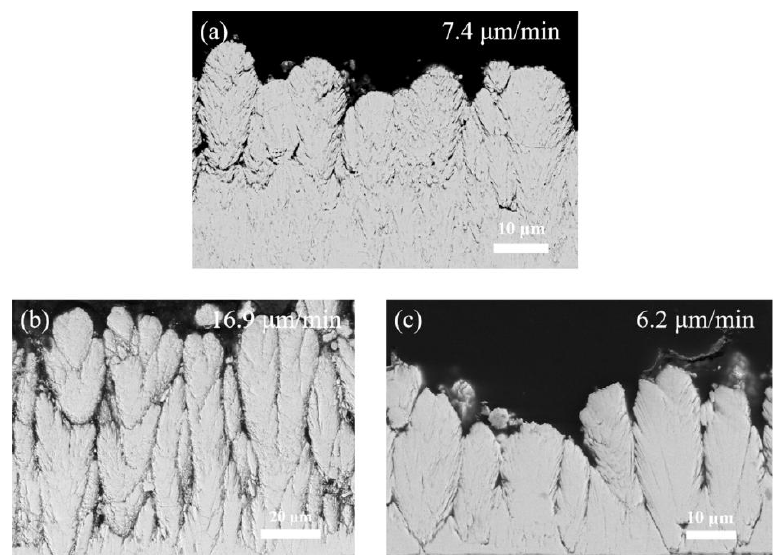
Figure 4. Cross-sectional morphologies of corresponding LC coatings: ( a ) Coating 1, ( b ) Coating 2, ( c ) Coating 3.